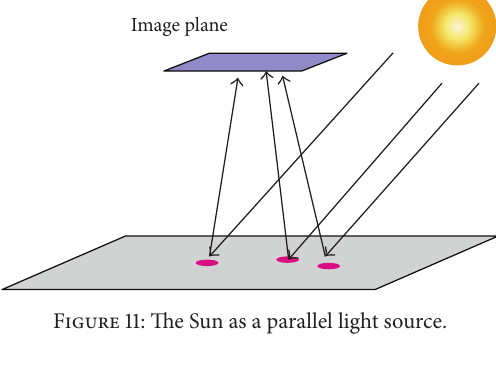
Figure 11: The Sun as a parallel light source.